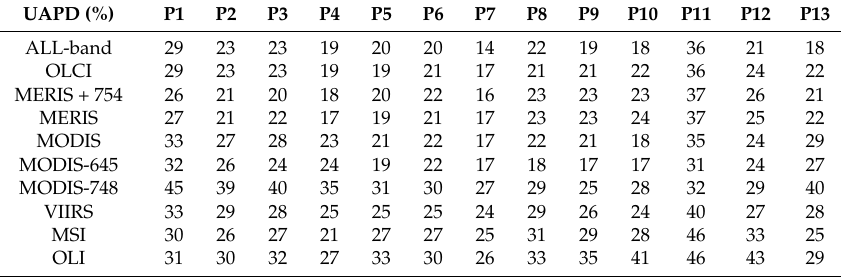
Table 6. For LE 2014: The unbiased absolute percentage differences (UAPD, %) of a Gau ( λ ) estimated from R rs ( λ ) with the original hyperspectral bands and those at different spectral configuration. P1–P13: 13 Gaussian peaks. MERIS+745: MERIS with the 745 nm band; MODIS-645/748: MODIS bands without 645 or 748 nm band.